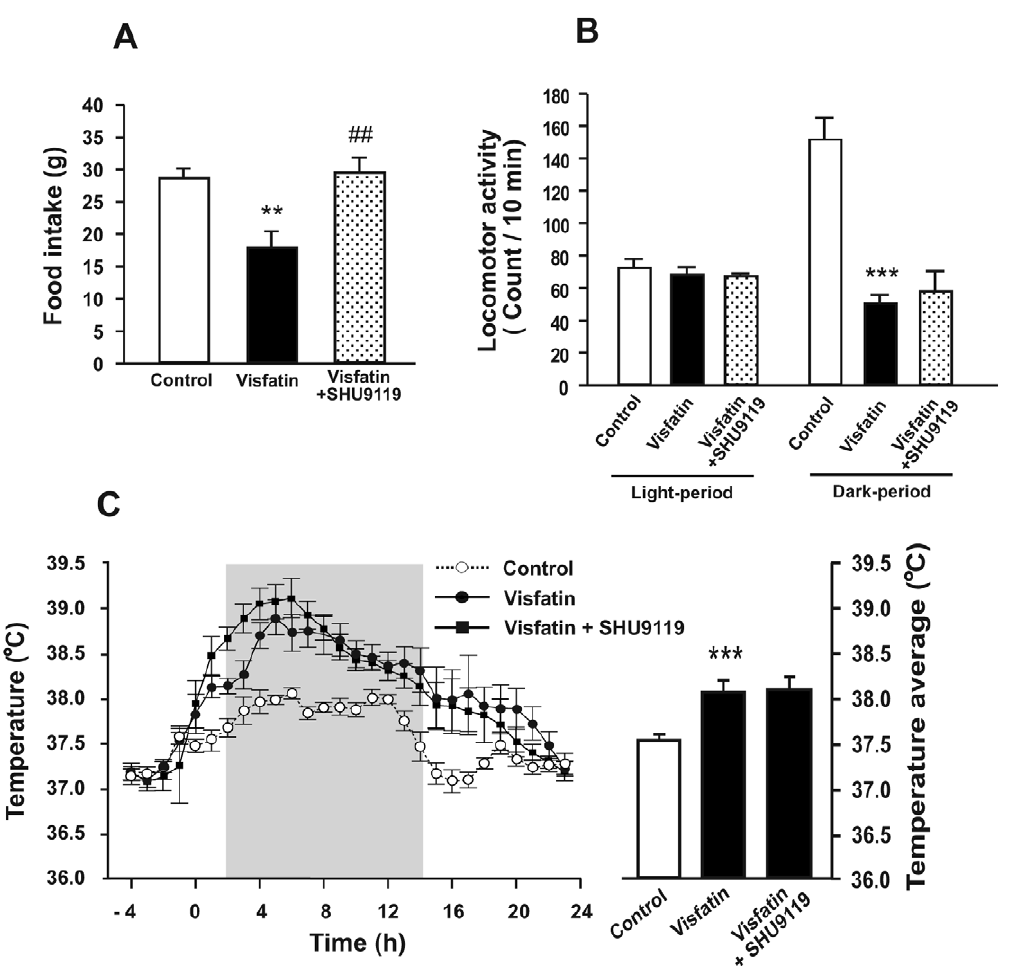
Figure 6. Effects of melanocortin receptors 3/4 antagonist on visfatin-induced sickness behaviors. Two-month-old male rats were ICV- injected with visfatin or vehicle 30 min after ICV injection of SHU9119 and were allowed access to food immediately after the final treatment. (A) Change in food intake was measured 24 h after the injections of SHU9119 and visfatin. (B, C) Changes in locomotor activity (B) and body temperature (C) were monitored in rats IP-implanted with telemetry-transmitters. In C, time 0 indicates visfatin injection. Data are represented as mean 6 SEM (n=6). **P , 0.01 and ***P , 0.001 vs. control rats injected with 0.9% saline solution; ## P , 0.01 vs. visfatin-injected rats. punched out under a stereomicroscope using a micro-punching set